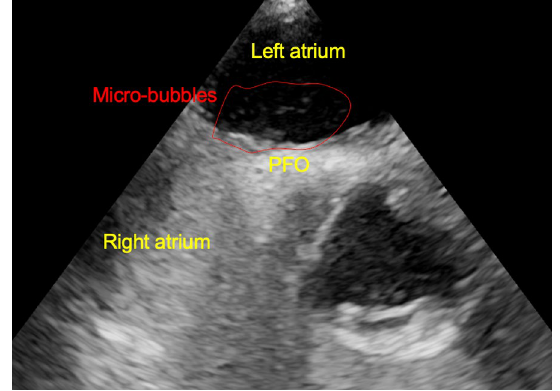
Fig. 7 Postoperative transesophageal ultrasound examination affording two- and four-chamber long-axis views of the heart. A small atrial septal defect was seen (ovale) by micro bubble test